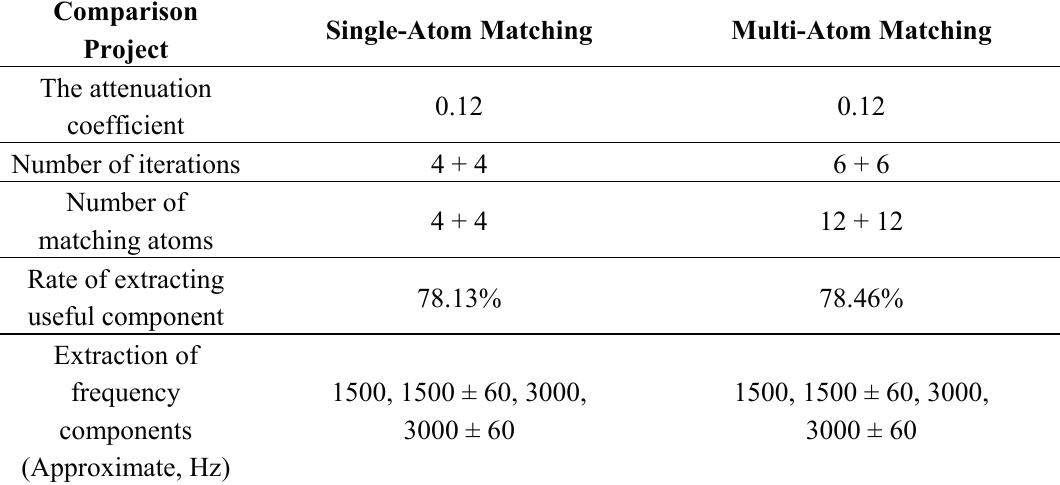
Table 5. Comparison